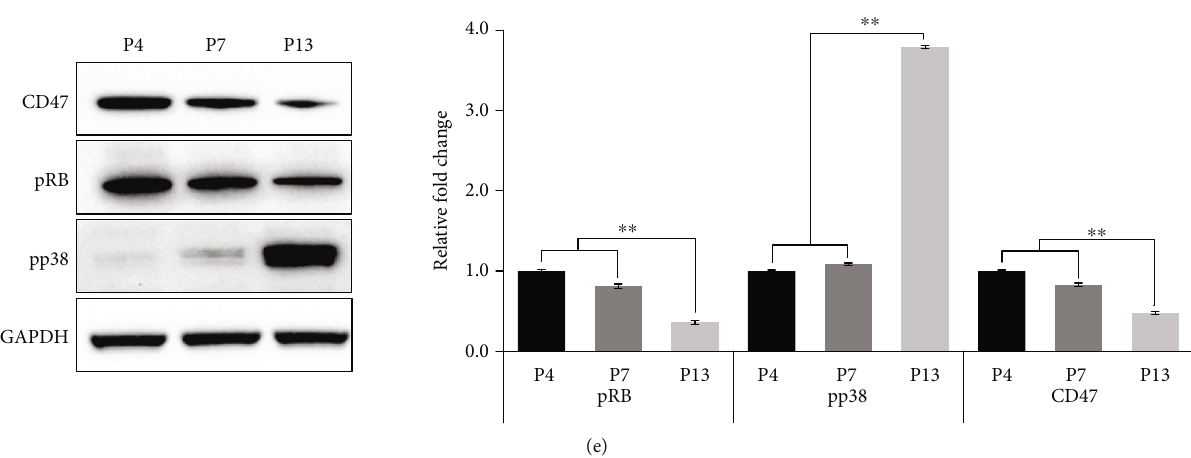
Figure 2: CD47 expressions and cellular senescence on late passages of UCB-MSCs were downregulated. (a) Flow cytometric analysis of CD47 expressions on UCB-MSCs during passaging was performed. (b) Representative immuno fl uorescence images of CD47-positive cells under passaging from passage 4 to 13. Scale bar 20 μ m. (c) Cell proliferation was determined by measuring fold changes, with results normalized to the growth observed at passage 4. (d) SA β -gal staining was performed on UCB-MSCs at passages 4, 7, and 13. SA β -gal positive cells were quanti fi ed by determining the percentages of stained cells. Scale bar 50 μ m. (e) Representative western blots of CD47, pRB, and pp38, cellular senescence-related markers, in UCB-MSCs subjected to passaging the cells. Semiquanti fi cation of protein expression levels of CD47, pRB, and pp38 was analyzed at passage 4 (P4), passage 7 (P7), and passage 13 (P13). Data is expressed as the mean ± SD ; n = 3 ; ∗∗ p < 0 : 01 , ∗ p < 0 : 05